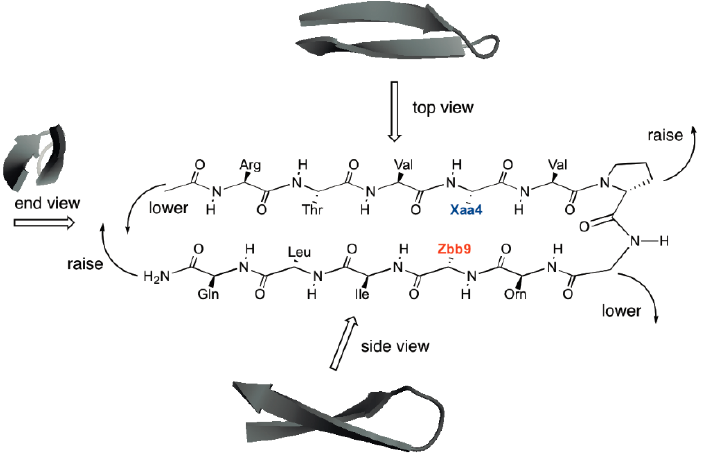
Figure 4. The chemical structure of HPTXaaZbb shown in perspective view, showing the conse- quence of the right-handed twist on a flat structure. The cartoon ribbon representation was gener- ated from the solution structure of an analog of the parent YKL peptide using PyMOL (pdb code 1JY9 [46]).